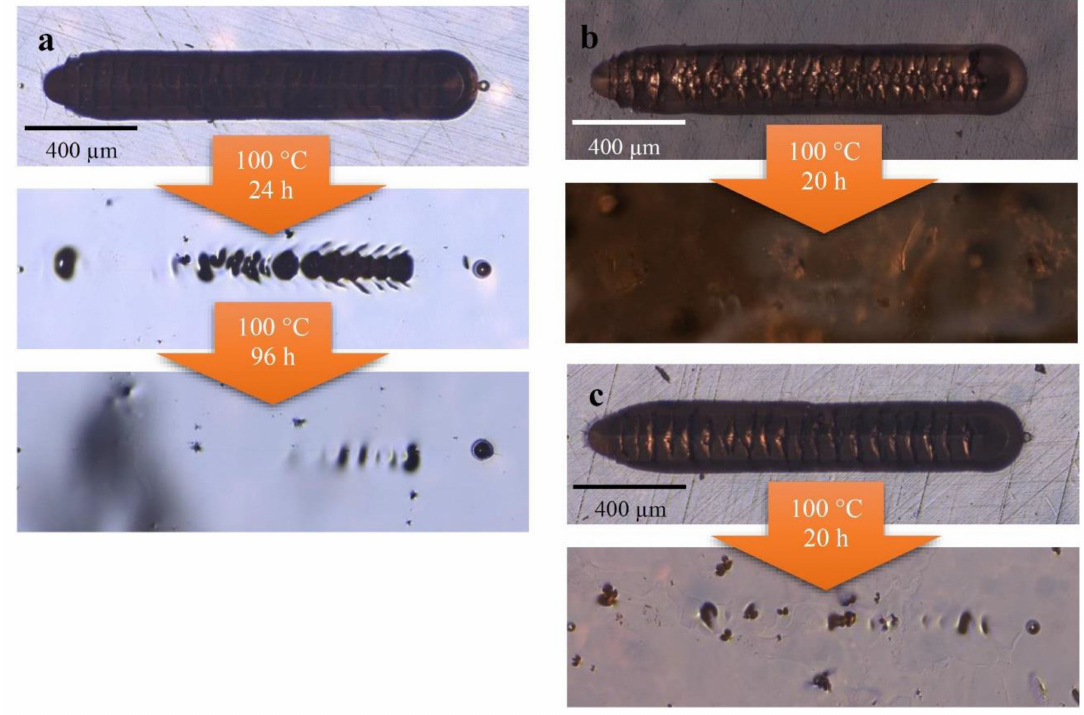
Figure 2. Healing experiments of the metallopolymers P2 ( a ), P3 ( b ), and P4 ( c ); microscopic pictures of the scratch before and after the annealing are